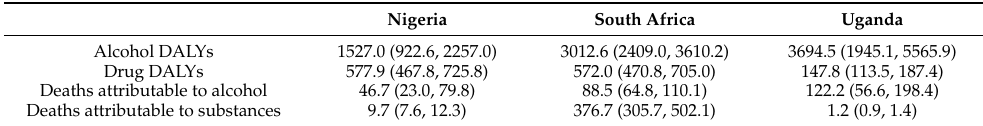
Table 2. Age-standardized estimates of DALYs and mortality per 100,000 people attributable to alcohol and other substances (95% uncertainty interval), Global Burden of Disease Study, 2016, by country